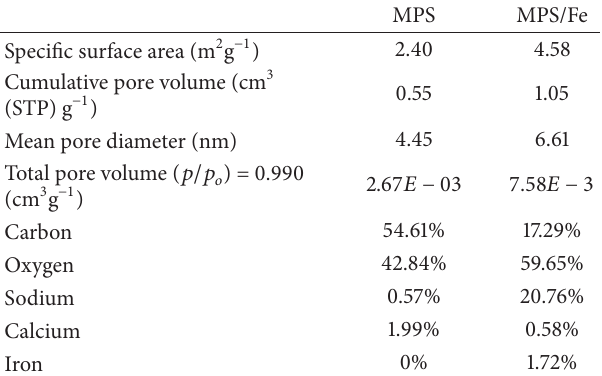
Table 2: Characteristics of catalytic